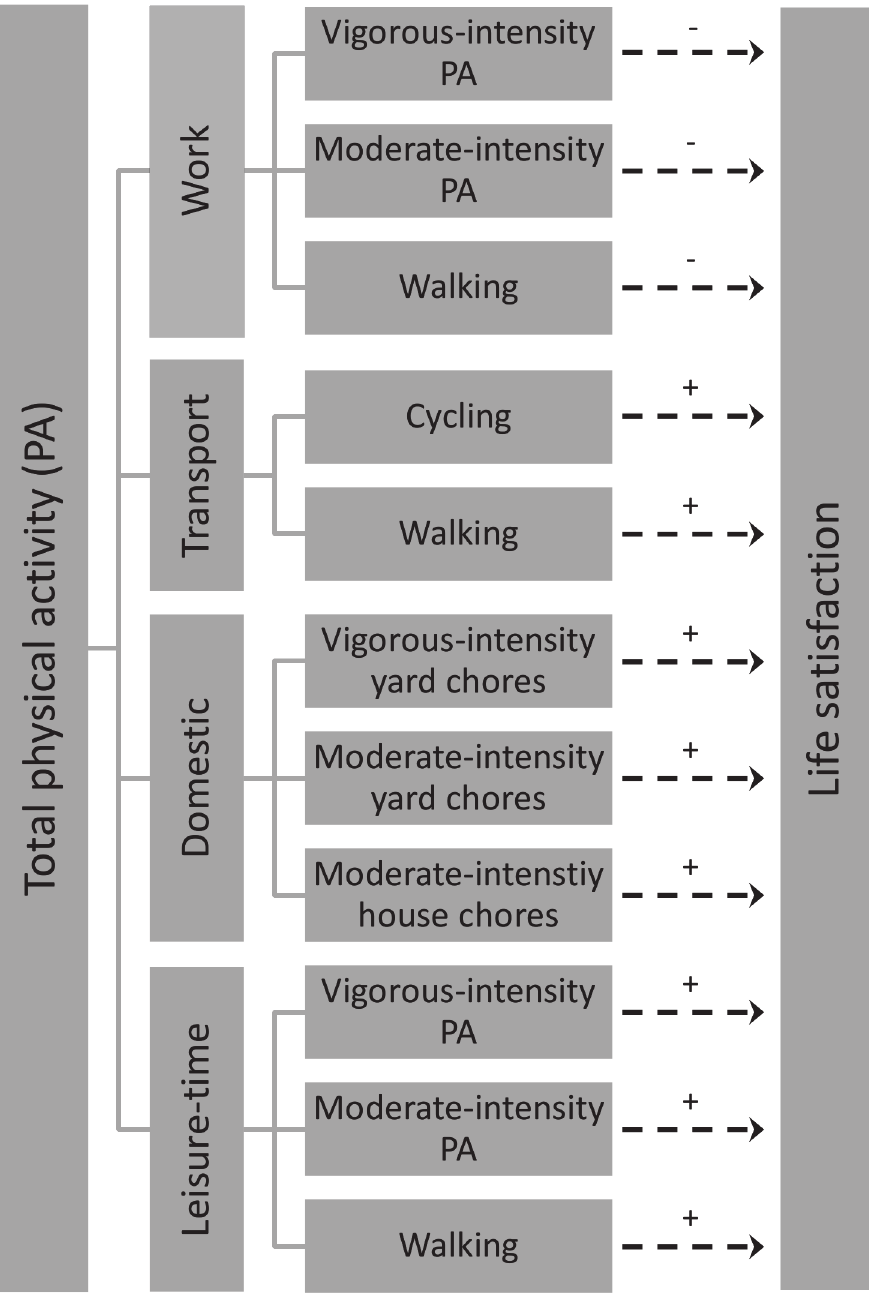
Fig 1. Hypothesised relationships between domain and intensity-specific physical activity levels and life satisfaction. Right dashed arrow : hypothesized relationship tested in the present study. Sign above the arrow : hypothesized direction of the relationship ( ‘ + ’ = positive; ‘ - ’ = inverse).